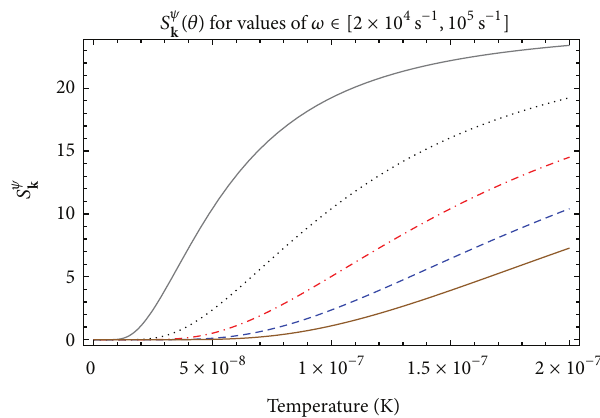
𝜓 k as a function of temperature